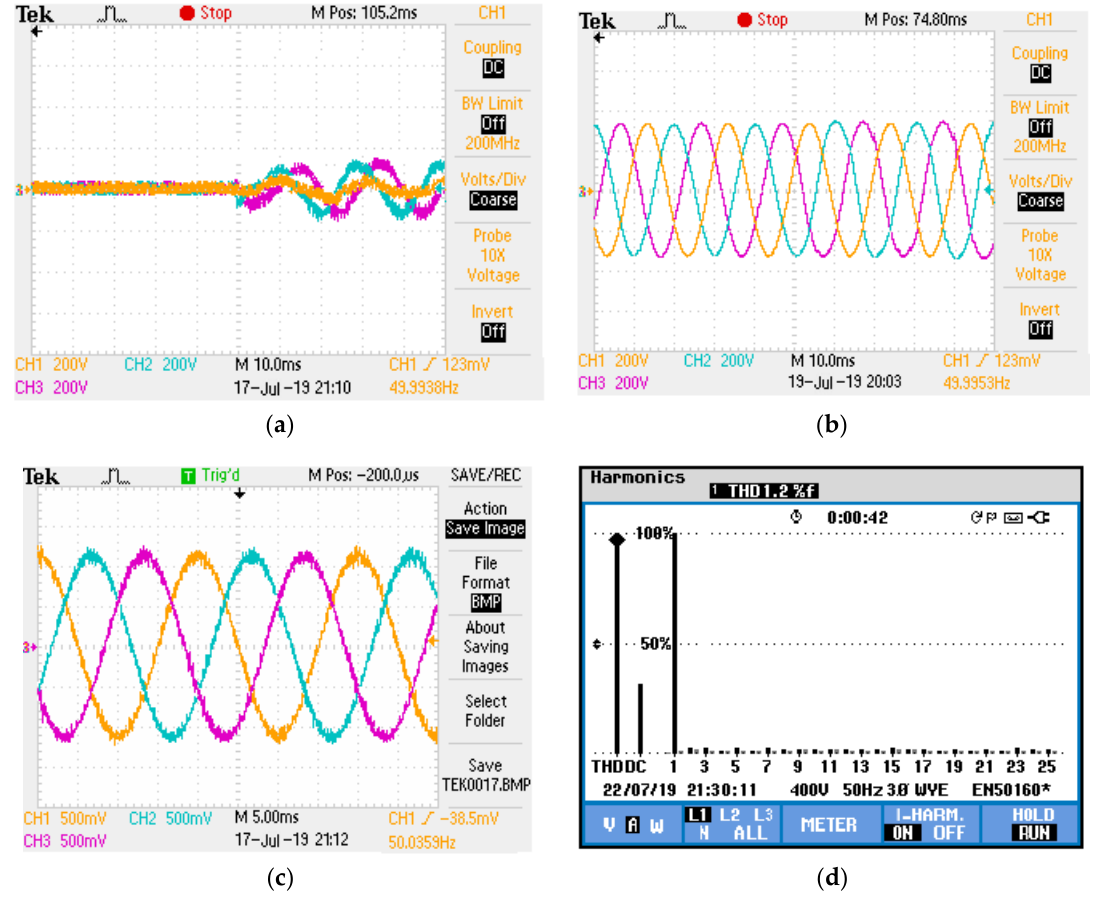
Figure 27. Experimental test results under unbalanced voltages with unequaled load currents: ( a ) shunt active power filter injected current; ( b ) source current; ( c ) injected series active power filter voltage; and ( d ) harmonic distortion after solar photovoltaic-unified power quality conditioner connection.